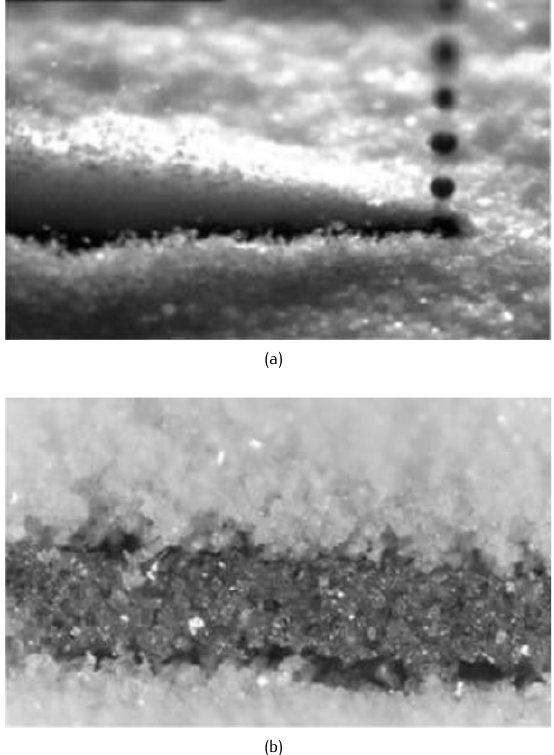
Figure 8. Powder-based 3D printing using inkjet printer, whereby the binder is ejected from the print head, onto a powder bed where it reacts and hardens to form a solid layer